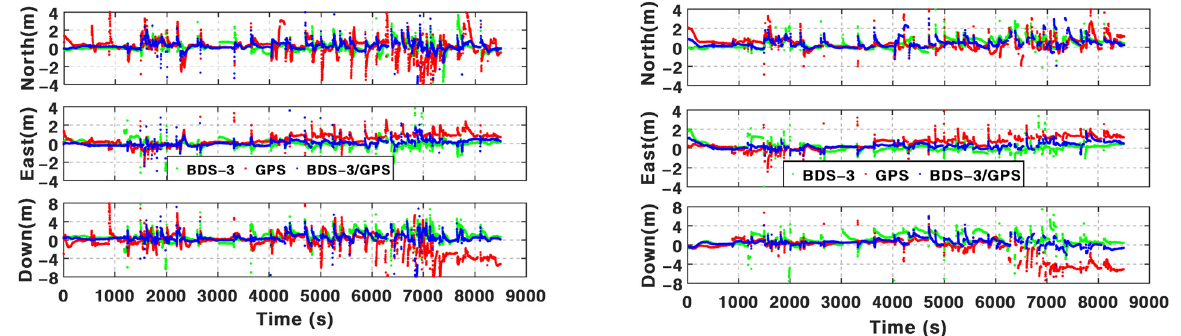
Figure 6. Positioning errors of undifferenced PPP ( left ) and BSSD PPP ( right ) with different GNSS. Table 2. Positioning errors of undifferenced PPP and BSSD PPP with different GNSS.